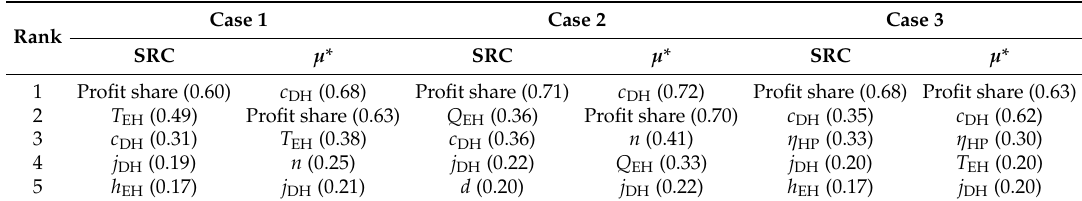
Table 8. Parameter significance ranking using linear regression of the MC simulations and the Morris screening the NPV of the first three case studies.